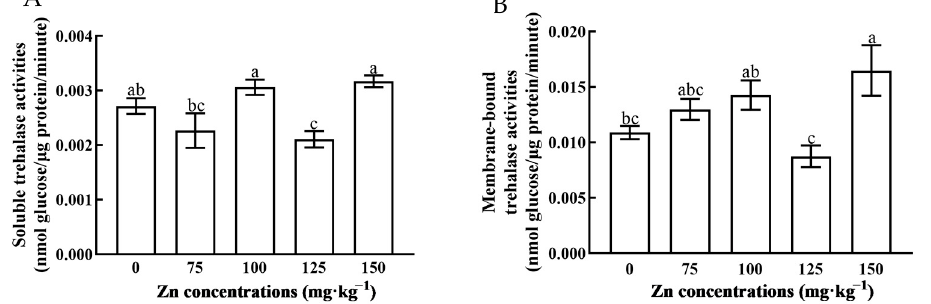
Figure 6. Effects of Zn accumulation in rice plants on the soluble ( A ) and membrane-bound ( B ) trehalase activities of N. lugens . The data are represented as mean ± SE ( n = 3). Tukey’s test was used to detect the significant differences among different groups, and different letters indicate significant differences.